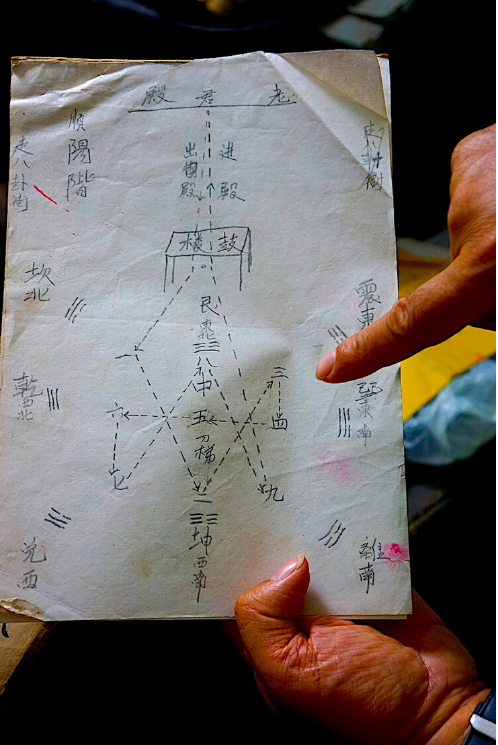
Figure 6. A diagram of the Yijing -inspired dance steps that evoke the “Kingdom of Heaven.” (Photo: Thomas Riccio).